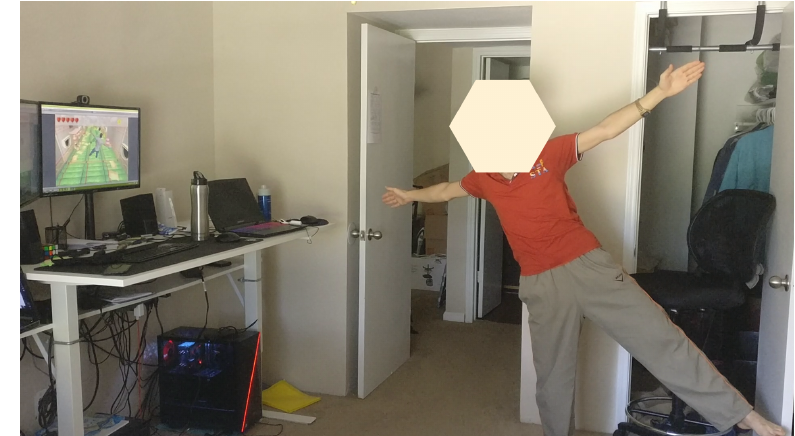
Figure 9. Screenshot of the setup environment showing one patient trying to replicate the virtual assistant